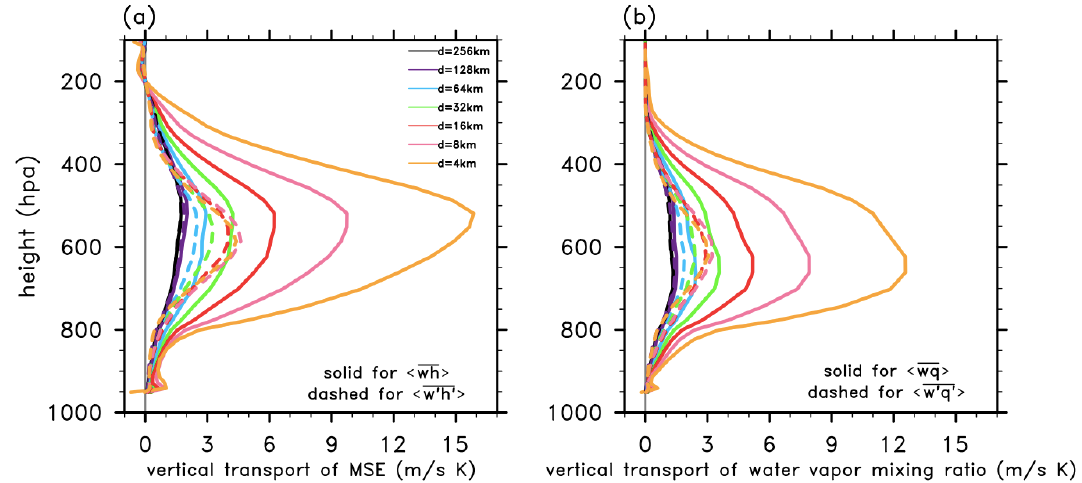
) ) for different subdomain sizes. 1/ 𝐶𝐶 𝑝𝑝 𝐿𝐿 / 𝐶𝐶 𝑝𝑝